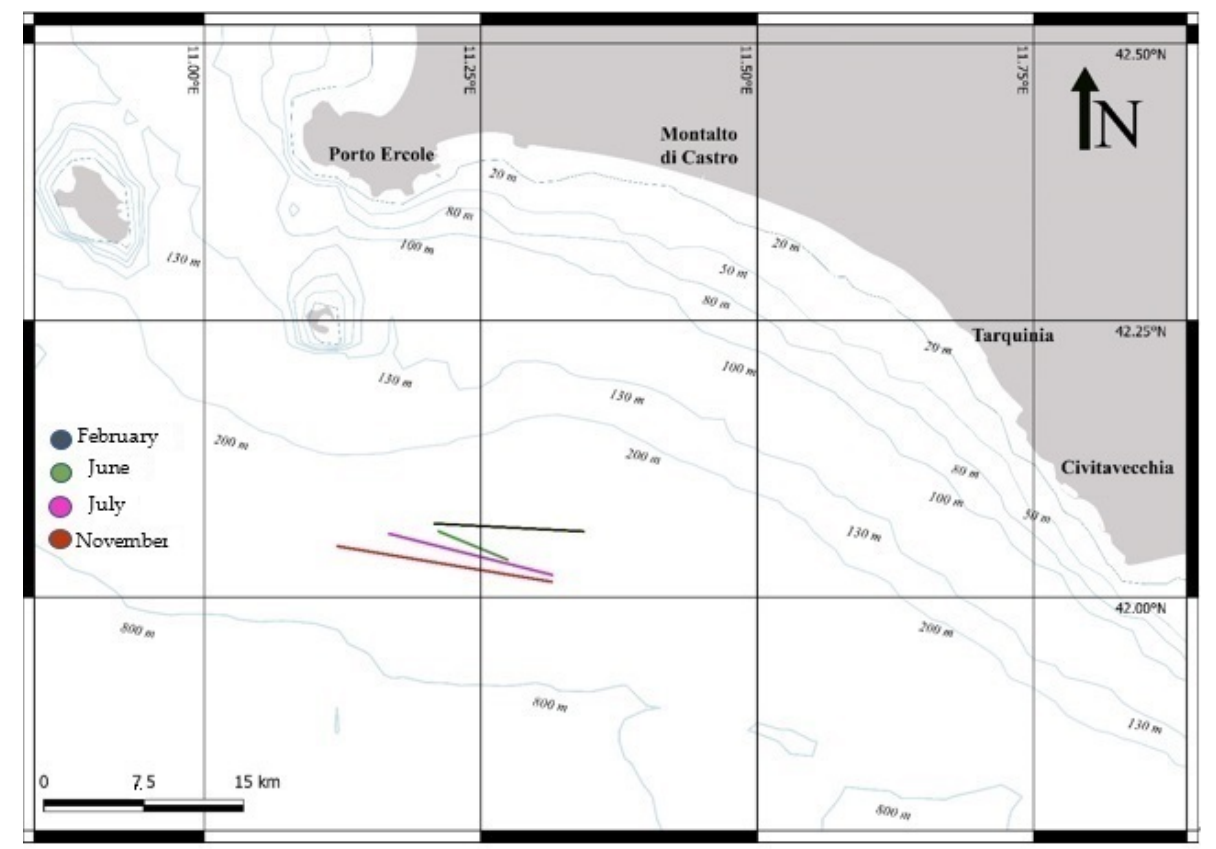
Figure 1. Study area with indications of bathymetry, main fishing harbors, and haul routes carried out during 2017 in the eastern central Tyrrhenian Sea (Italy) (from [50]).